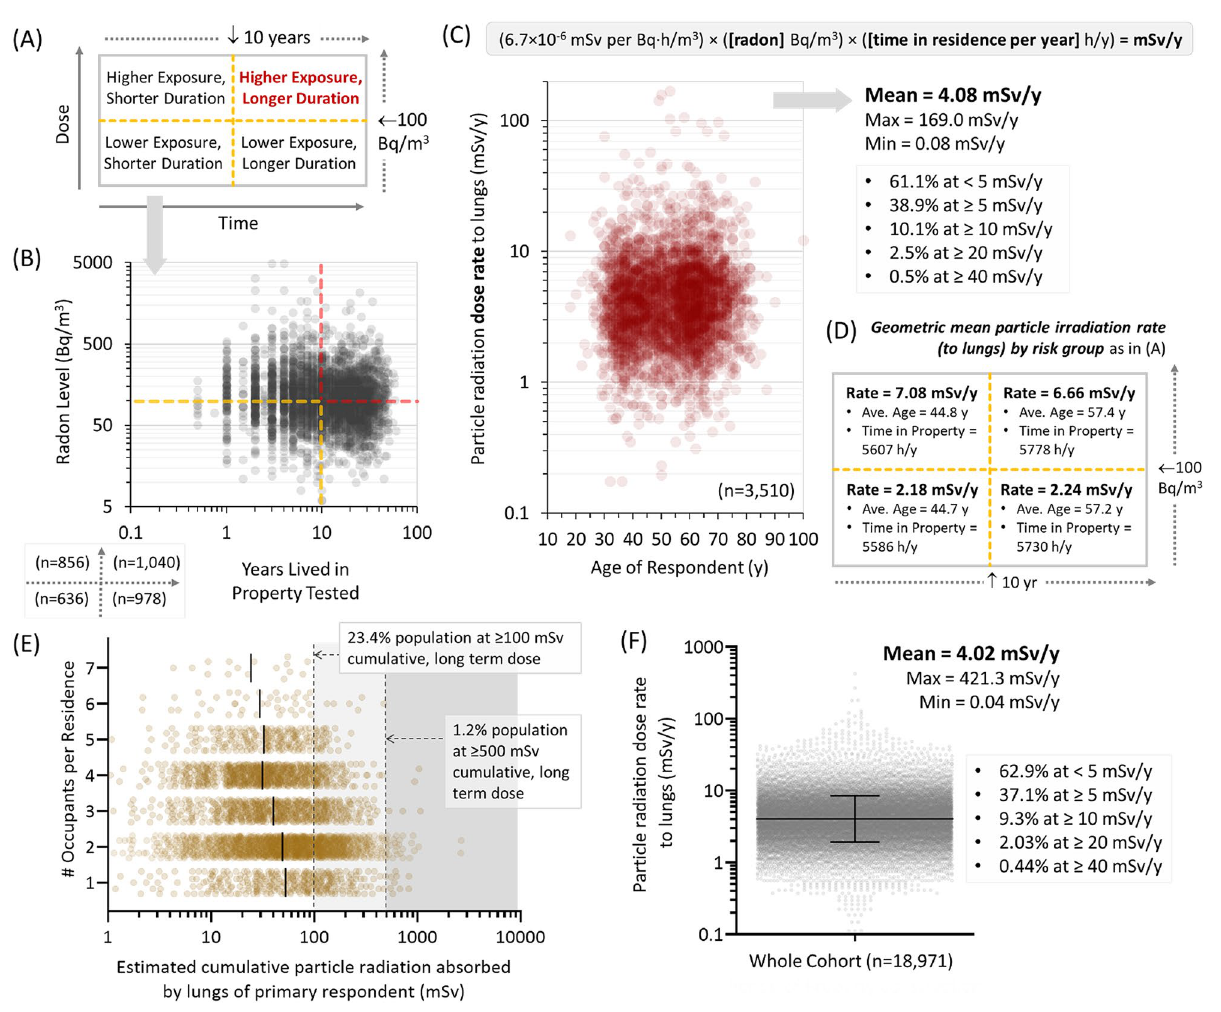
Figure 2. Yearly and cumulative particle radiation exposure from radon inhalation. ( A ). Rubric delineating residential radon exposure (high exposure = ≥ 100 Bq/m 3 ) as a function of the amount of time a participant reports living in that property (long exposure = ≥ 10 y). ( B ) Residential radon exposure as a function of years lived in that environment, with red and yellow lines demarcating exposure brackets outlined in ( A ). ( C ) Using the indicated formula from ICRP (see methods), Bq/m 3 radon levels were combined with exposure durations to derive mSv/y particle radiation dose rates, expressed as a function of participant age. The geometric mean dose rate and the percent of the cohort experiencing < 5, ≥ 5, ≥ 10, ≥ 20, or ≥ 40 mSv/y are indicated. ( D ) The particle radiation dose rate (mSv/y) was broken down by exposure brackets outlined in ( A ), additionally indicating the geometric mean of participant ages and the time they reported spending in their primary residence per year. ( E ) The estimated cumulative particle radiation exposure for all primary respondents (in mSv) was expressed as a function of the number of occupants for that specific property. ( F ) The particle radiation dose rate (mSv/y) for the larger cohort of radon tested, properties (n = 18,971) was estimated using the geometric mean amount of time each participant reported spending per year in the primary residence (5549 h/y). The geometric mean annual particle dose rate and the percent of the cohort experiencing < 5, ≥ 5, ≥ 10, ≥ 20, or ≥ 40 mSv/y are To gain a sense of cumulative particle radiation exposure over the amount of time that each individual spent within the radon-tested environment, we next multiplied dose rates by the amount of time each person reported living full time in that property, and expressed these values as a function of the number of occupants. For the purposes of modelling, we operated on the assumption that radon levels within each property did not fluctuate significantly from year to year over the long term. This is supported by our previous work that found no year- on-year variations in the collective radon test outcome for North American large populations 12 , and the fact that all participants in this cohort verified that they had not engaged in any type of radon mitigation of their primary residence at any time before surveying. Estimated, cumulative particle radiation doses were an aver- age of 40–50 mSv, with 23.4% of the population receiving ≥ 100 mSv, and 1.2% receiving ≥ 500 mSv to the lungs over the long term from residential radon inhalation (Fig. 2E). To estimate mSv/y particle radiation dose rates for a much larger population, we used the average amount of time our cohort spent in their primary residence